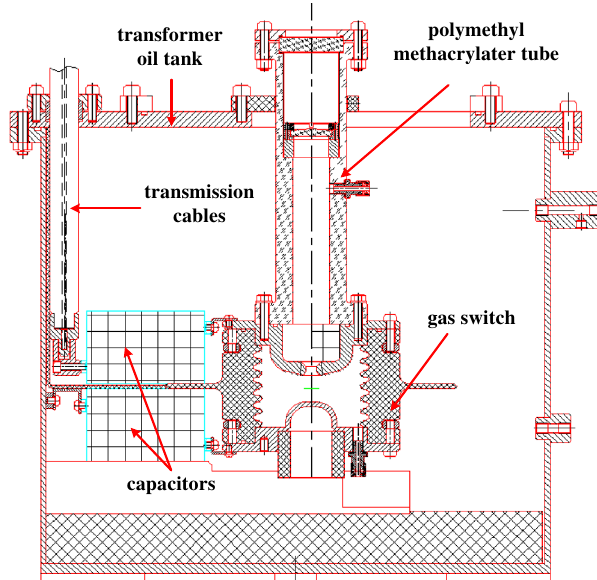
FIG. 3. The layout of the trigger unit. A resistor divider is fielded between one end of the upper capacitor and the trans- former oil tank shell to diagnose the output of the trigger unit. The gas switch uses dry air with a gas pressure of about 0.38 MPa. Its working ratio is roughly 43% and the jitter is only about 2 ns.